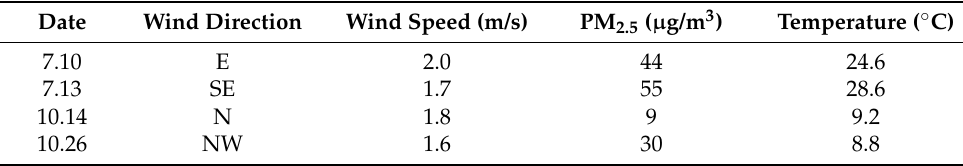
Table 1. Meteorological data of national control stations on simulation dates.